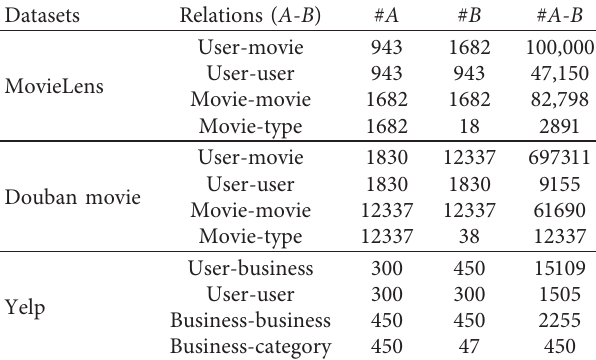
Table 1: Statistics of the three